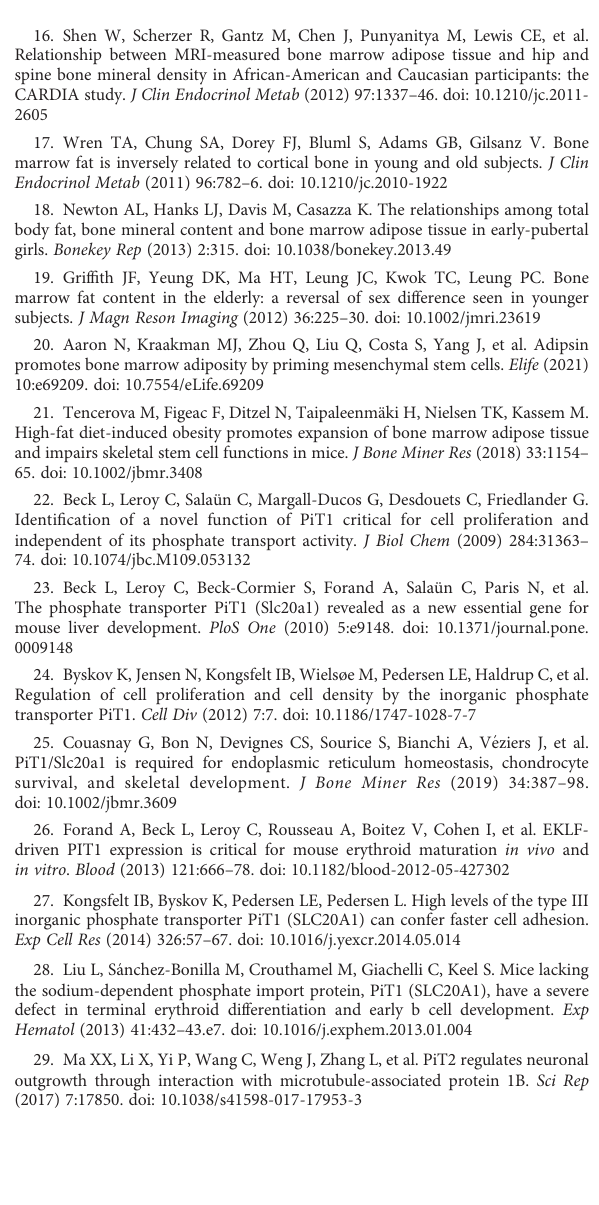
Adipogenic differentiation of BMSCs from PiT2 -/- males. (A) Left - Representative images of PiT2 +/+ and PiT2 -/- BMSCs after adipogenic differentiation and ORO staining. Scale bar = 100 m m. Right - Graphs showing the percentage of oil-red O (ORO) positive cells related to the total number of Hoechst-positive cells (left) and ORO absorbance at 520nm (right). (B) Relative PiT1 , Adiponectin and FABP4 mRNA expression at 0 and 7 days of differentiation, n are indicated on graph bars. Data are means ± SEM, Mann-Whitney